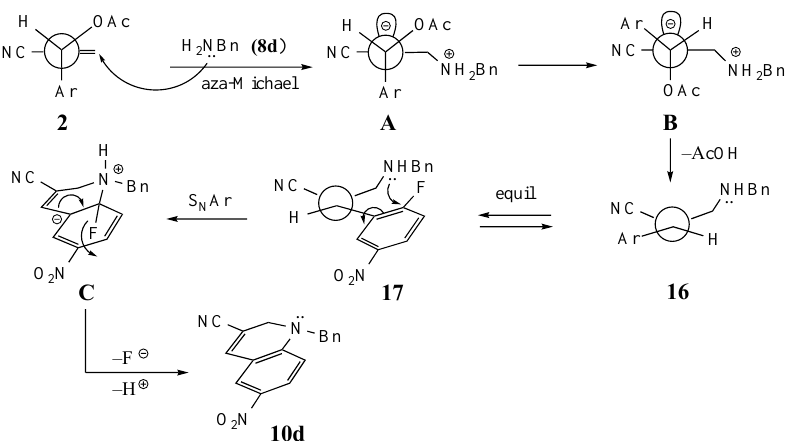
Scheme 1. Plausible mechanism for the formation of dihydroquinoline 10d from MBH acetate 2 and amine 8d .